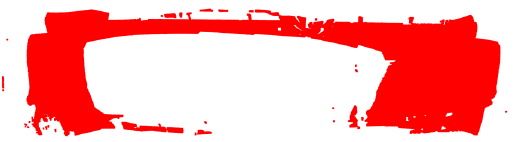
Figure 23. The complete 3D point cloud of the stitched vehicle nose.